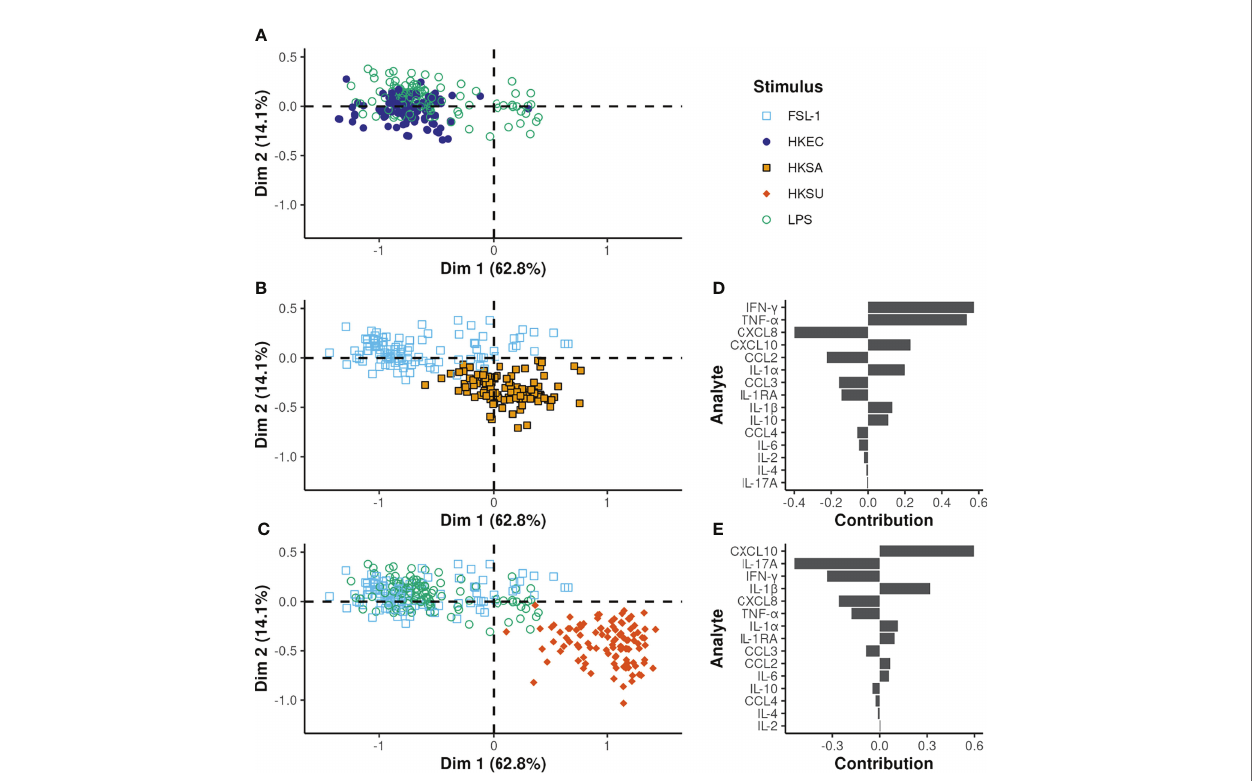
FIGURE 7 | Multilevel PLS-DA on all bacteria and TLR ligands except GDQ. (A – C) output of the same PLS-DA but displaying only one bacterial stimulus and the TLR ligands known to activate the same TLR. The x and y-axes correspond to the fi rst and second PLS-DA components, respectively. The proportion of variance explained by each principal component is given in brackets. (D, E) the variable contributions to the fi rst and second components,